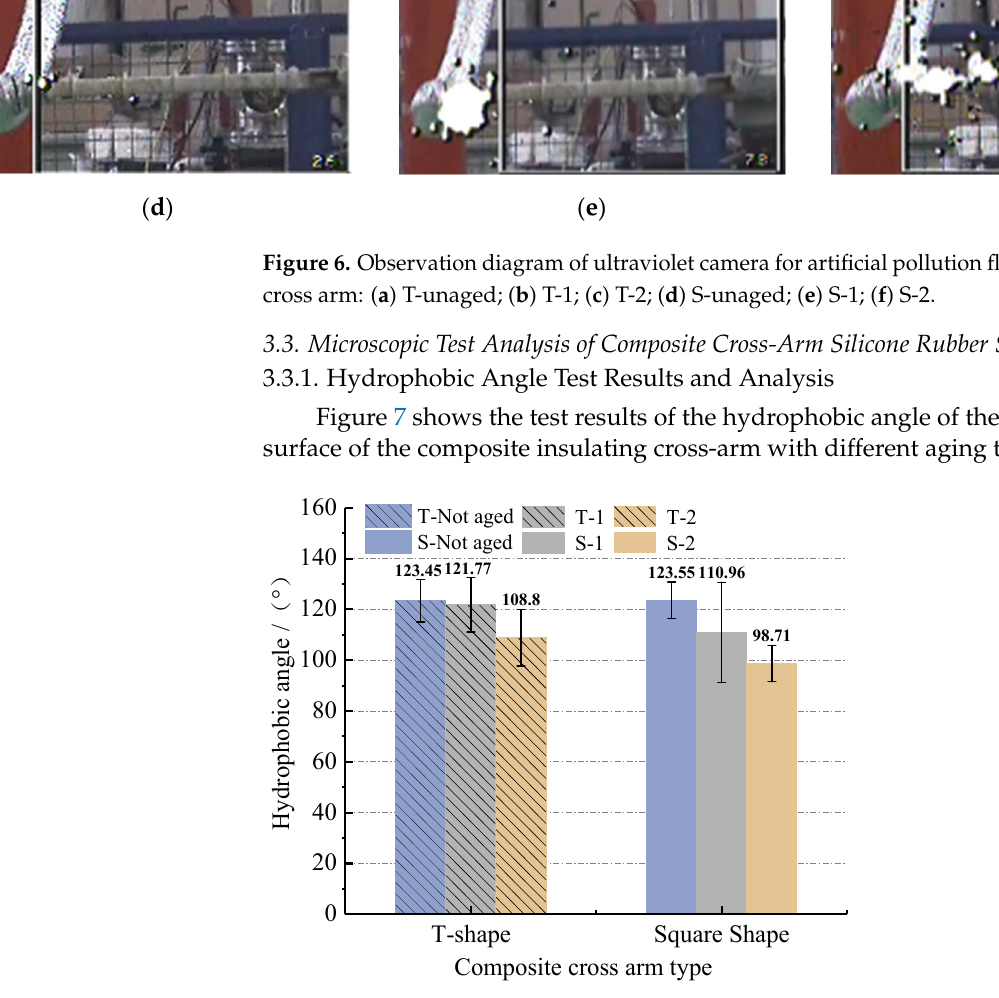
Figure 7. Measurement results of hydrophobic angle of composite cross-arm silicone rubber with different aging types.